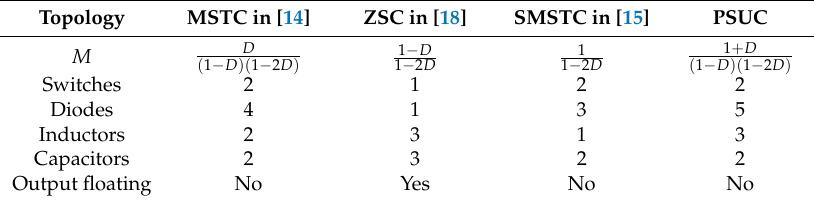
Table 5. Comparisons among the converters.